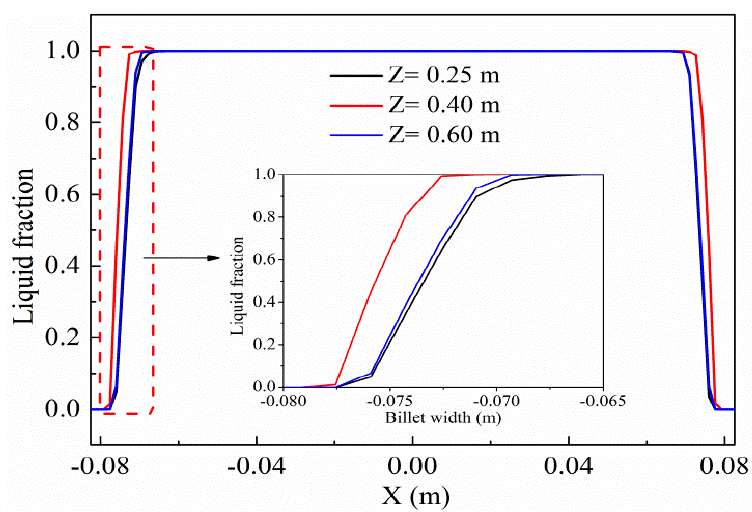
Figure 5. Predicted liquid fraction profiles at different cross sections.